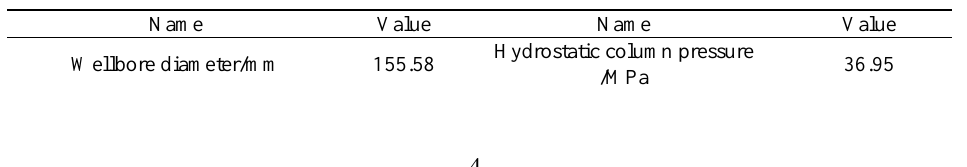
Table 1 . Parameters of FEM